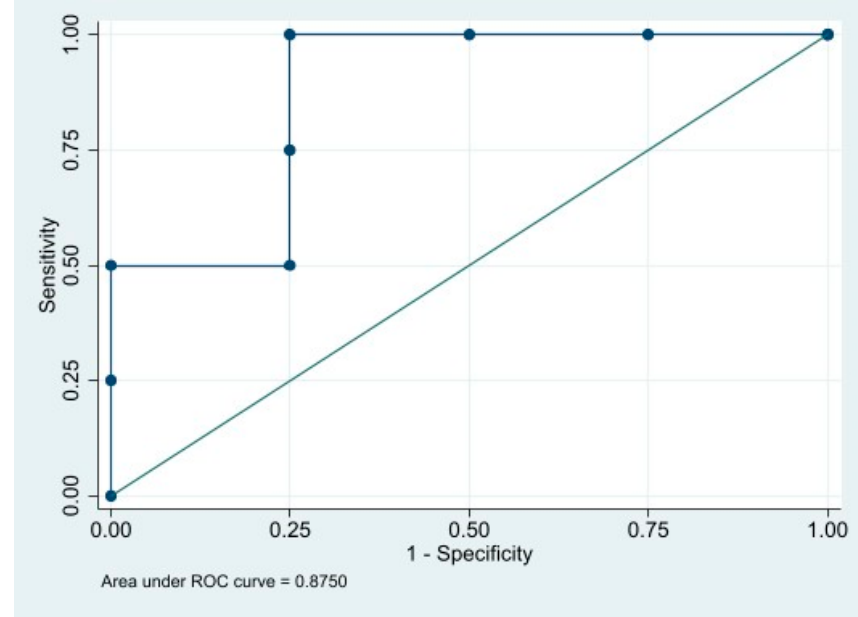
Figure 2. Logistic model for predicting the risk of heat-related